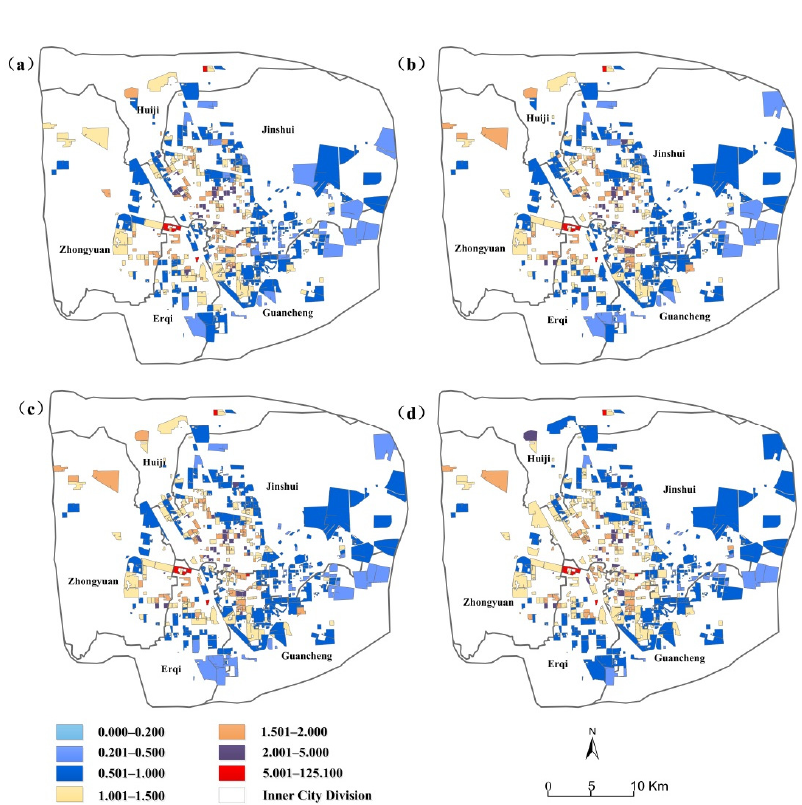
Figure 4. The distribution of the GVI values at the community level (( a ) GVI of 360 m, ( b ) GVI of 720 m, ( c ) GVI of 1080 m, and ( d ) GVI of 2160 m).